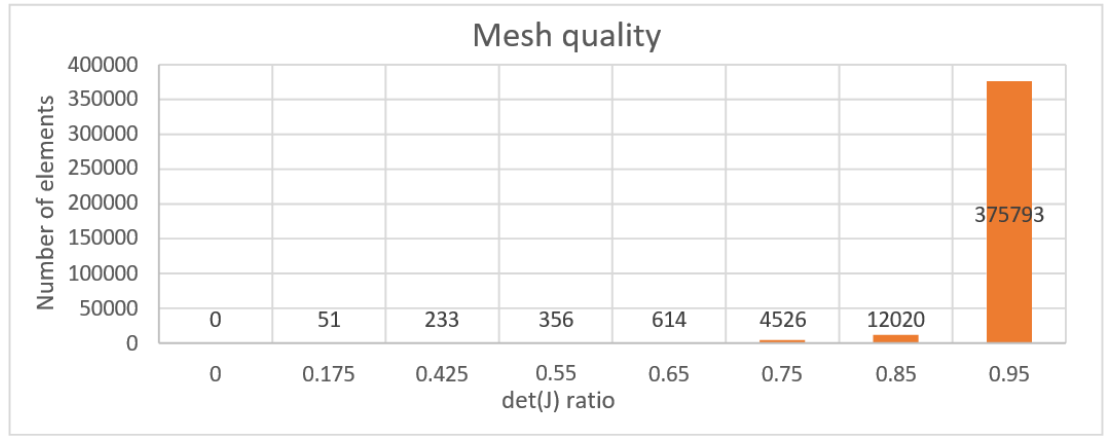
Figure 13. Typical CFD mesh quality distribution graph—number of elements versus Jacobian determinant det(J) ratio